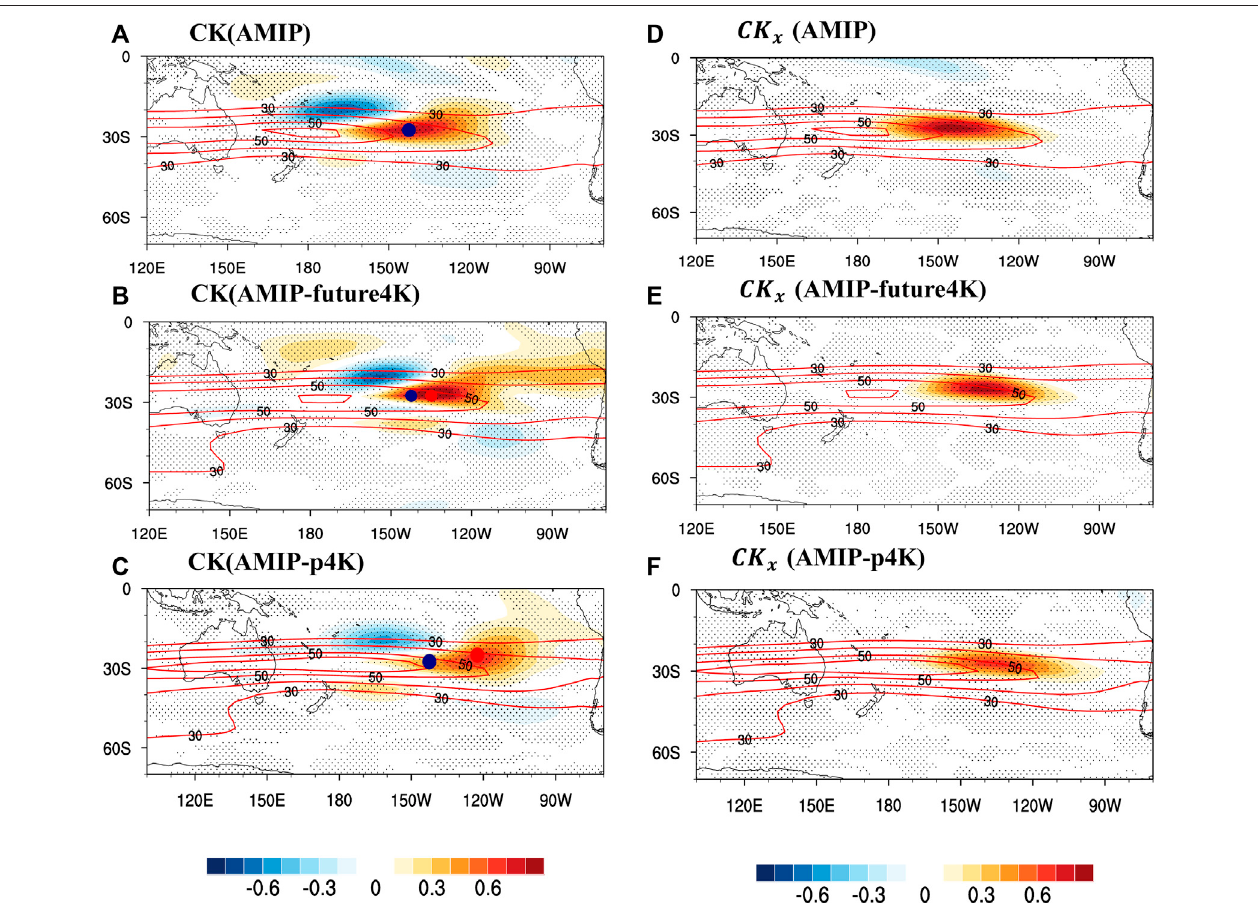
FIGURE3| MMEoftheJJAclimatologicalzonalwind(contourlines;m/s)andCK(shadingina – c;m 2 /s 3 )andCK x (shadingind – f;m 2 /s 3 )in (A , D) AMIP, (B , E) AMIP- future4K,and (C , F) AMIP-p4K.Thedotsindicatethatmorethan70%ofmodelsagreeonthesignoftheMME.ThenavydotdenotesthecentralpositionoftheCKinthe mid-latitudes in AMIP, and the red dots in (B , C) denote the central position of the CK in the mid-latitudes in AMIP-future4K and AMIP-p4K, respectively. (C) Role of the